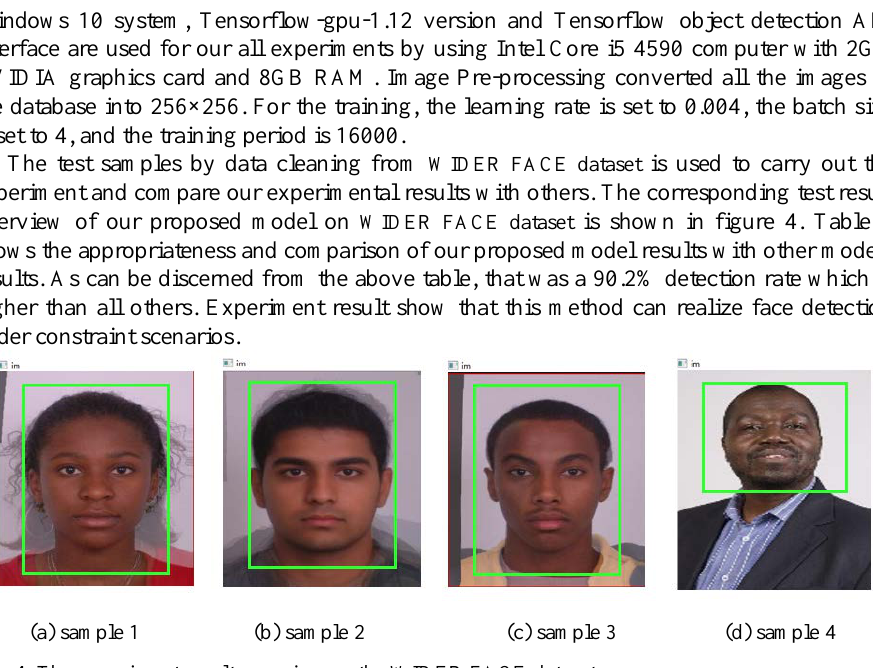
Fig. 4. The experiment result overview on the WIDER FACE